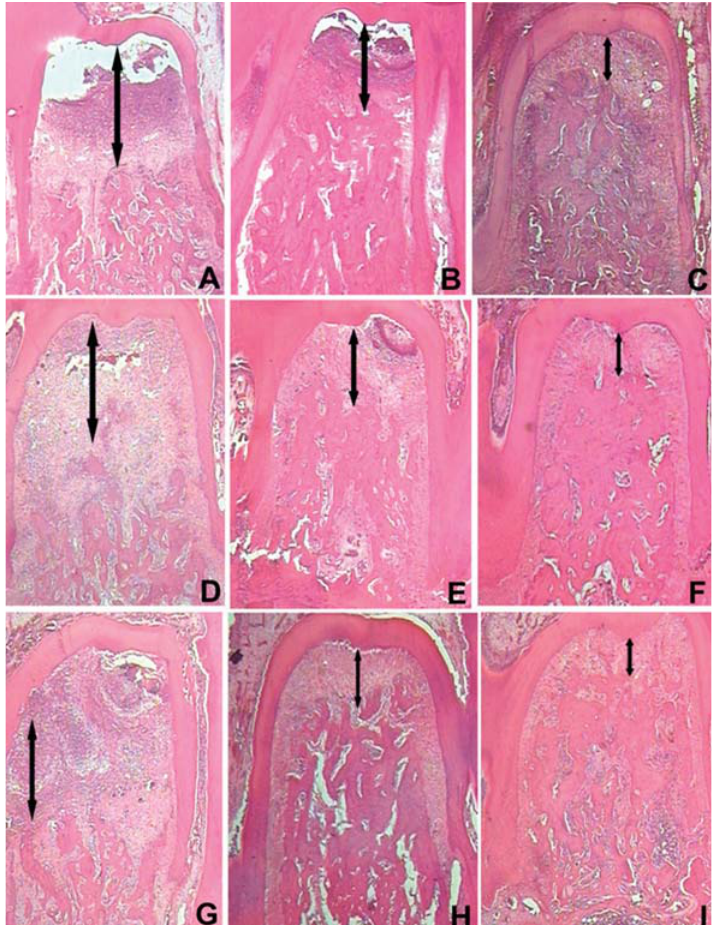
Figure 4- (cid:3)(cid:51)(cid:75)(cid:82)(cid:87)(cid:82)(cid:80)(cid:76)(cid:70)(cid:85)(cid:82)(cid:74)(cid:85)(cid:68)(cid:83)(cid:75)(cid:86)(cid:3)(cid:76)(cid:79)(cid:79)(cid:88)(cid:86)(cid:87)(cid:85)(cid:68)(cid:87)(cid:76)(cid:81)(cid:74)(cid:3)(cid:87)(cid:75)(cid:72)(cid:3)(cid:68)(cid:85)(cid:72)(cid:68)(cid:86)(cid:3)(cid:82)(cid:73)(cid:3)(cid:37)(cid:47)(cid:3)(cid:76)(cid:81)(cid:3)(cid:87)(cid:75)(cid:72)(cid:3)(cid:73)(cid:88)(cid:85)(cid:70)(cid:68)(cid:87)(cid:76)(cid:82)(cid:81)(cid:3)(cid:85)(cid:72)(cid:74)(cid:76)(cid:82)(cid:81)(cid:3)(cid:82)(cid:73)(cid:3)(cid:87)(cid:75)(cid:72)(cid:3)(cid:79)(cid:72)(cid:73)(cid:87)(cid:3)(cid:191)(cid:85)(cid:86)(cid:87)(cid:3)(cid:80)(cid:68)(cid:81)(cid:71)(cid:76)(cid:69)(cid:88)(cid:79)(cid:68)(cid:85)(cid:3)(cid:80)(cid:82)(cid:79)(cid:68)(cid:85)(cid:86)(cid:3)(cid:90)(cid:76)(cid:87)(cid:75)(cid:3)(cid:76)(cid:81)(cid:71)(cid:88)(cid:70)(cid:72)(cid:71)(cid:3)(cid:83)(cid:72)(cid:85)(cid:76)(cid:82)(cid:71)(cid:82)(cid:81)(cid:87)(cid:68)(cid:79)(cid:3) (cid:71)(cid:76)(cid:86)(cid:72)(cid:68)(cid:86)(cid:72)(cid:17)(cid:3)(cid:50)(cid:85)(cid:76)(cid:74)(cid:76)(cid:81)(cid:68)(cid:79)(cid:3)(cid:80)(cid:68)(cid:74)(cid:81)(cid:76)(cid:191)(cid:70)(cid:68)(cid:87)(cid:76)(cid:82)(cid:81)(cid:3)(cid:20)(cid:21)(cid:59)(cid:17)(cid:3)(cid:43)(cid:40)(cid:17)(cid:3)(cid:36)(cid:3)(cid:177)(cid:3)(cid:49)(cid:55)(cid:3)(cid:74)(cid:85)(cid:82)(cid:88)(cid:83)(cid:15)(cid:3)(cid:26)(cid:3)(cid:71)(cid:68)(cid:92)(cid:86)(cid:30)(cid:3)(cid:37)(cid:3)(cid:16)(cid:3)(cid:54)(cid:53)(cid:51)(cid:3)(cid:74)(cid:85)(cid:82)(cid:88)(cid:83)(cid:15)(cid:3)(cid:26)(cid:3)(cid:71)(cid:68)(cid:92)(cid:86)(cid:30)(cid:3)(cid:38)(cid:16)(cid:3)(cid:54)(cid:3)(cid:74)(cid:85)(cid:82)(cid:88)(cid:83)(cid:15)(cid:3)(cid:26)(cid:3)(cid:71)(cid:68)(cid:92)(cid:86)(cid:30)(cid:3)(cid:39)(cid:3)(cid:177)(cid:3)(cid:49)(cid:55)(cid:3)(cid:74)(cid:85)(cid:82)(cid:88)(cid:83)(cid:15)(cid:3)(cid:20)(cid:24)(cid:3)(cid:71)(cid:68)(cid:92)(cid:86)(cid:30)(cid:3)(cid:40)(cid:3)(cid:16)(cid:3)(cid:54)(cid:53)(cid:51)(cid:3) group, 15 days; F- S group, 15 days; G – NT group, 30 days; H - SRP group, 30 days; I- S group, 30 days